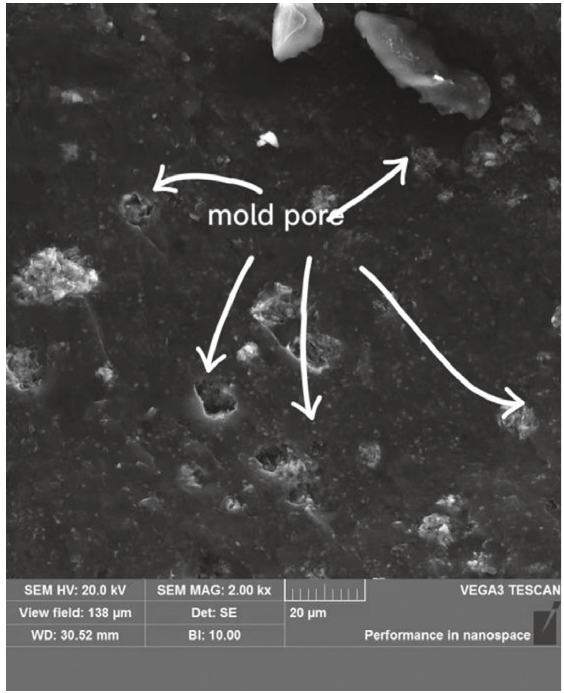
Figure 4: Detrital substances in cell cavity pores 2. Figure 6: Complex form of mold hole